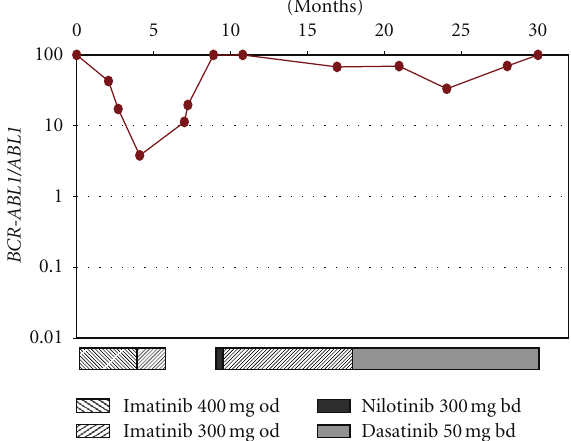
Figure 1: RQ-PCR monitoring of e19a2 BCR-ABL1